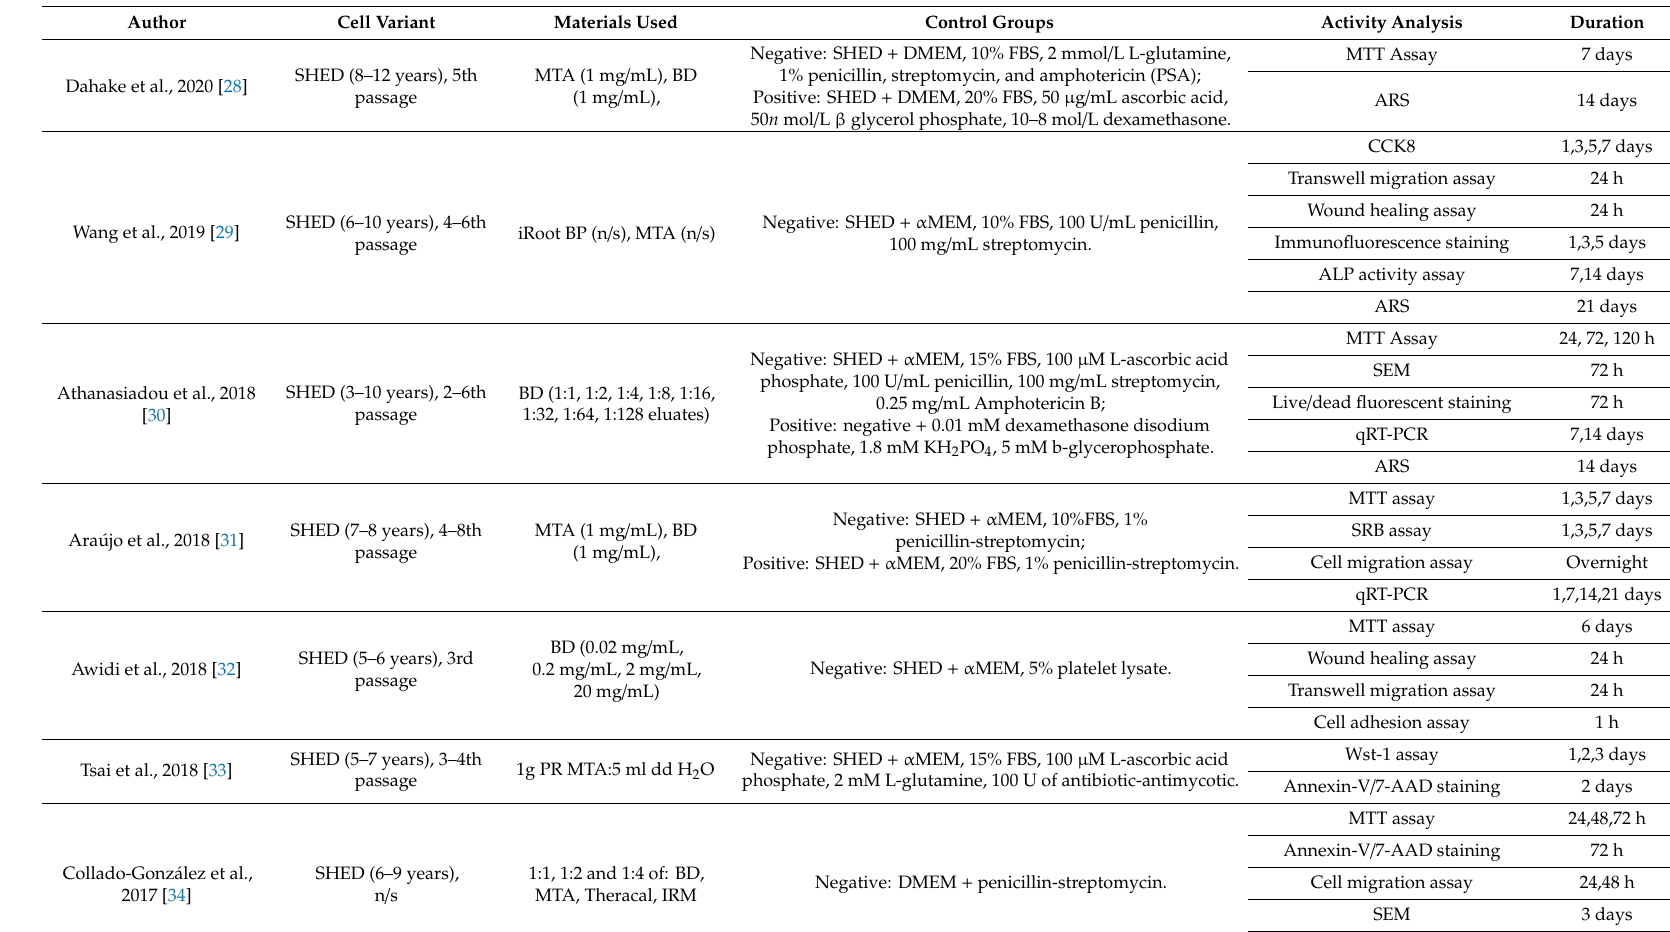
Table 2. Summary of the methodology of the included